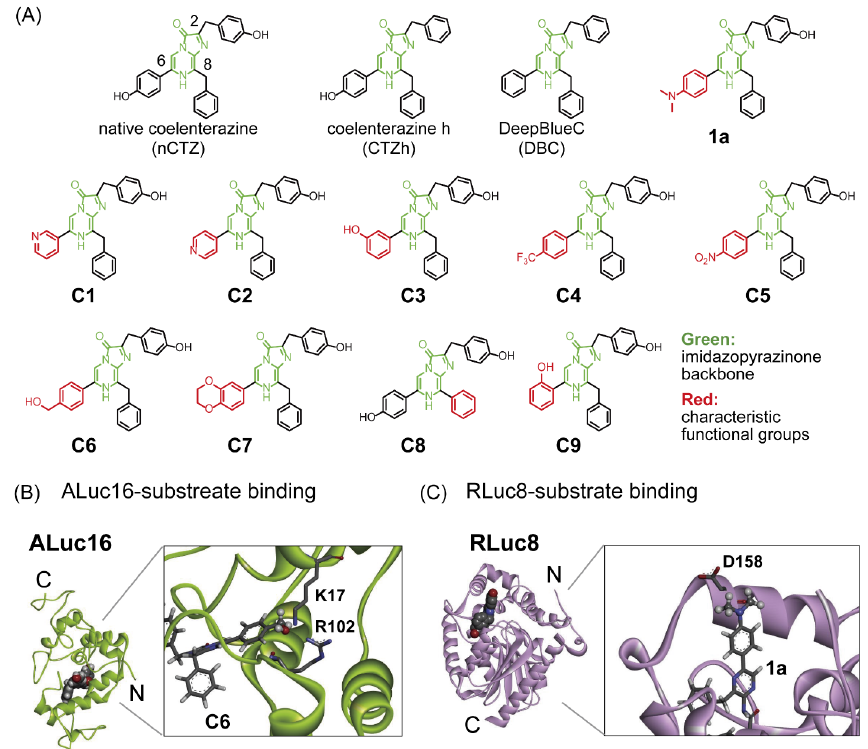
Figure 1. ( A ) Chemical structures of the CTZ analogues used in this study. The imidazopyrazinone backbone is highlighted in green. The characteristic functional groups are highlighted in red. Ab- breviations: nCTZ, native coelenterazine; CTZh, coelenterazine h; DBC, DeepBlueC. 1a . Our previ- ously reported CTZ analogue, which shows the BL intensity for the RLuc series. ( B ) Three-dimen- sional (3D) structure of ALuc16 with nCTZ, which was modeled based on the structure of GLuc. The active site is highlighted in the box to show the specific interactions with the substrate C6 . The hydroxymethyl (OH-CH 2 -) group of C6 (represented by balls) was manually created by extending the corresponding functional group from the nCTZ. ( C ) The 3D structure of Renilla luciferase 8 (RLuc8) with coelenteramide. The active site is highlighted in the box to show the specific interac- tions with 1a . The dimethylamino group ((CH 3 ) 2 N-) group of 1a (represented by balls) was manually fabricated by extending the corresponding functional group from the bound coelenteramide. Puta- tive interacting residues are represented by sticks.